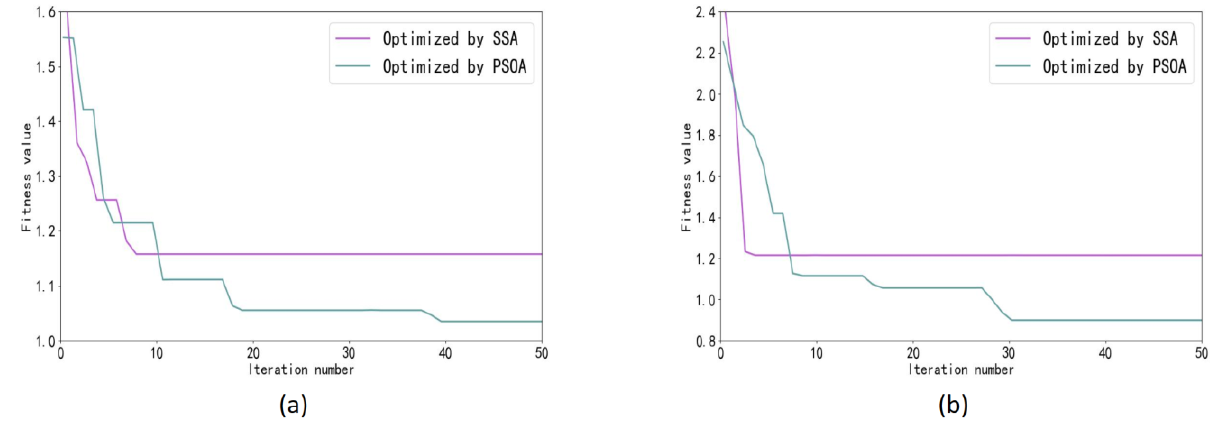
Figure 15. Optimal fitness value curve: ( a ) V 2 = 5000 mm/min best fitness value curve, ( b ) V 3 = 8000 mm/min best fitness value curve.